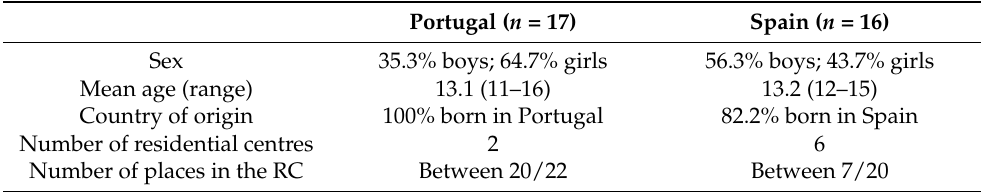
Table 1. Characteristics of the participants according to residential centres and countries.